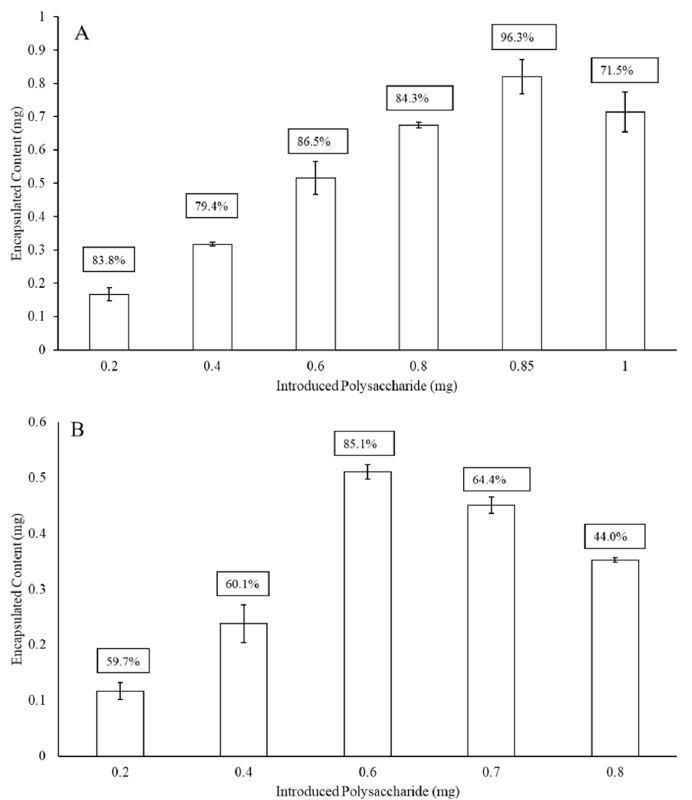
Figure 2. Liposomal polysaccharide encapsulation efficiency (boxed values; without surface protein addition) of serotype 4 ( A ) and 3 ( B ) as a function of initial polysaccharide introduced to the LEPS formulation process.